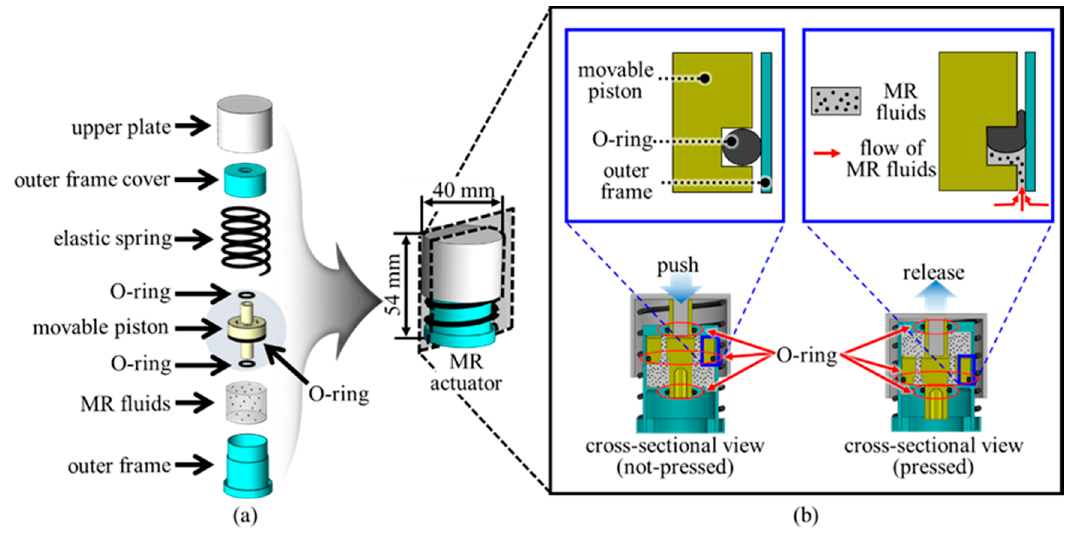
Figure 2. Structure of the proposed MR actuator: ( a ) Schematic illustration of the proposed MR actuator; ( b ) Its operating principle.